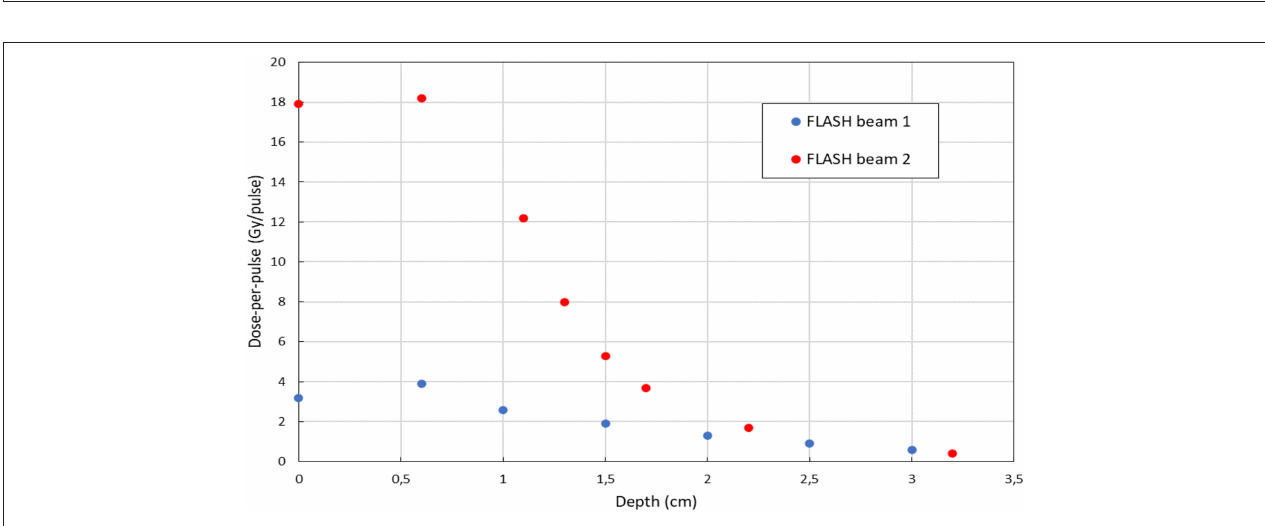
FIGURE 8 | Beam FWHM measured at different depths inside solid water with FLASH beam 1 (blue) and FLASH beam 2 (red), with the corresponding dose-per-pulse.